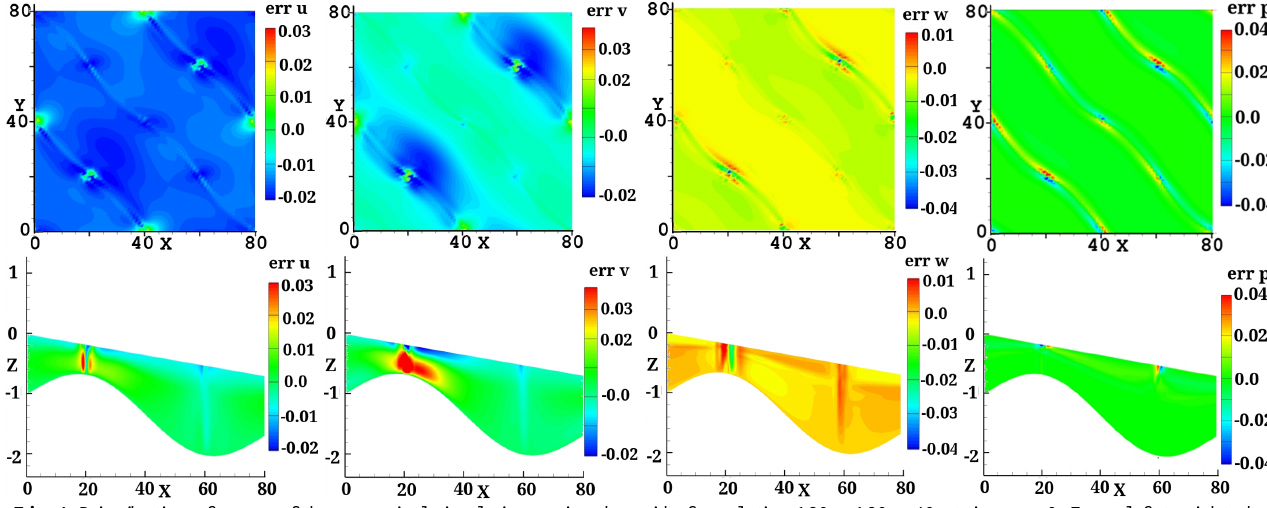
Fig. 4. Distribution of errors of the numerical simulations using the grid of resolution 160 × 160 × 40 at time t = 0. From left to right: the velocity components u , v and w (ma − 1 ) and the pressure p (10 5 Pa). Top row: on the top surface, bottom row: along the cross section y = L/